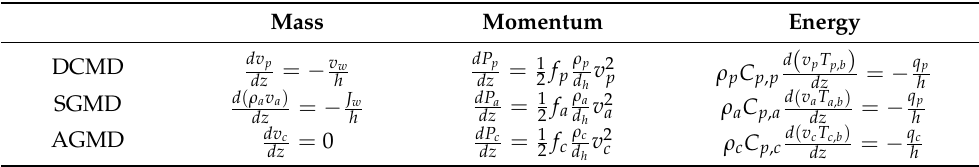
Table 2. Balance equations in the permeate channel of DCMD and SGMD and coolant channel in